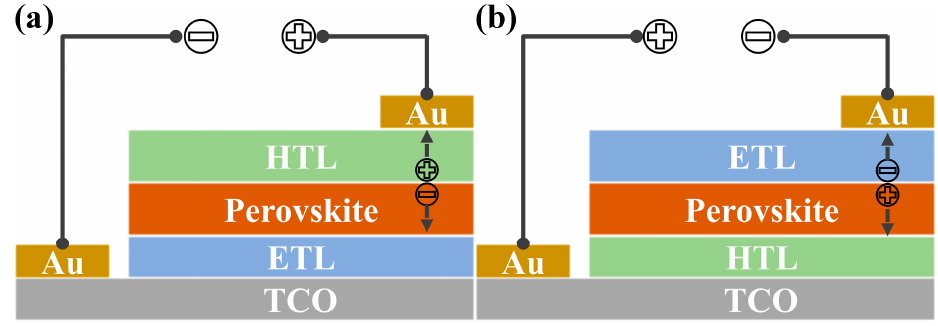
Figure 1. Device con fi gurations of n-i-p ( a ) and p-i-n ( b ) PSCs.